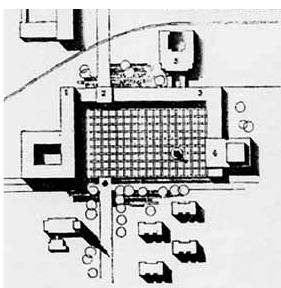
fig. 3. one of the plans for the Sztálinváros (Dunaújváros) city center